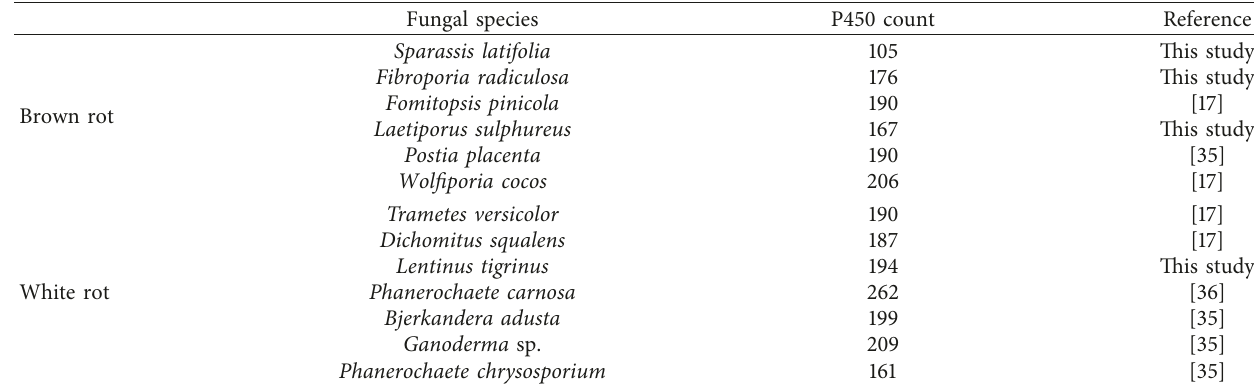
Table 3: CYP450 genes identified in fungal